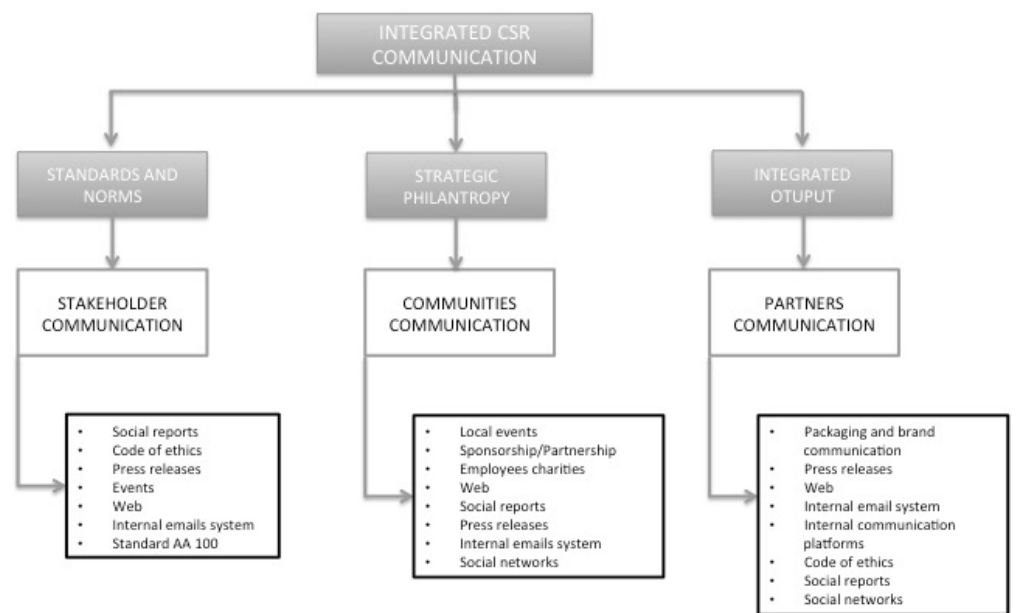
Figure 2: The Sustainability Communication